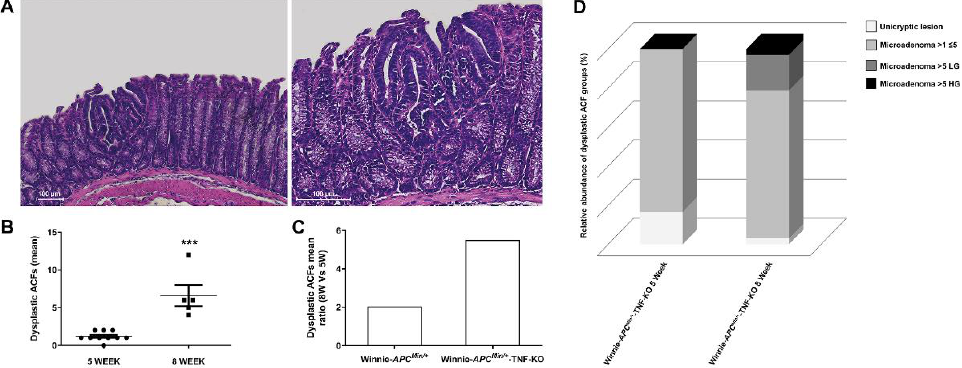
Figure 2. Histological analysis of Winnie- APC Min/+ -TNF-KO mice at 5 and 8 weeks. ( A ) Hematoxylin and eosin staining on 3 μm distal colon sections of 8 -wk-old Winnie- APC Min/+ -TNF-KO mice. Images were captured at 10X (left) and 20X magnifications (right). CAC progression from 5 to 8 weeks was calculated for Winnie- APC Min/+ -TNF-KO mice as the mean of dysplastic ACFs ( B ) and reported as the mean ratio between 8 and 5 weeks for Winnie- APC Min/+ -TNF-KO mice and the already published Winnie- APC Min/+ model [28] ( C ). Data reported in B as dot plots represent the mean ± SEM. ( D ) Histograms reporting dysplastic ACFs composition in terms of dimension and grading for Winnie- APC Min/+ -TNF-KO mice at 5 and 8 weeks; 5 weeks: n = 9 – 10 animals/group; 8 weeks: n = 5 – 8 animals/group. *** p < 0.001. TNF: tumor necrosis factor; CAC: colitis-associated cancer; ACFs: aberrant crypt foci.